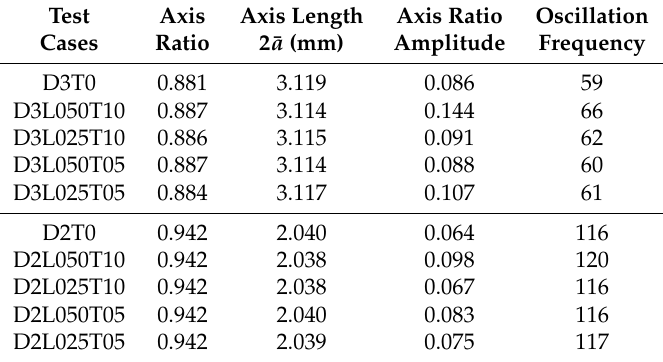
Table 4. Comparison of the time-averaged drop axis ratios, horizontal axis lengths, axis ratio amplitudes and oscillation frequencies of the simulated falling water drops in both stagnant and turbulent surroundings. Test Axis Axis Length Axis Ratio Oscillation Cases Ratio 2¯ a